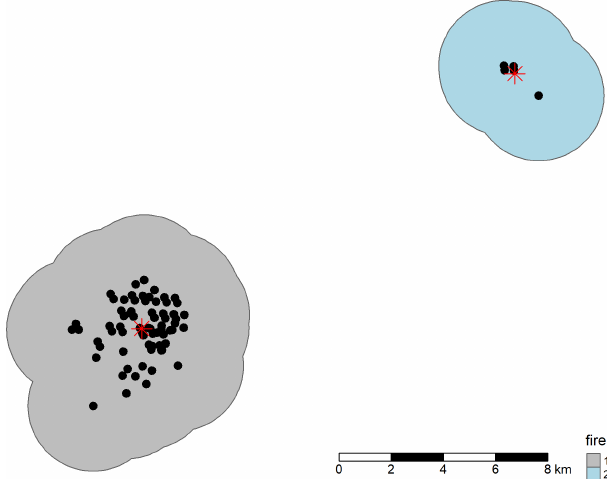
Figure 2. Example of creating clusters from VIIRS SNPP hotspots. Black dots are hotspots; red asterisks are fire centroids, i.e. the arith- metic mean of the hotspot coordinates. The image has two sepa- rate fires. Each hotspot is buffered by 2.5km, with all overlapping buffers merged and hotspots given separate identity numbers based on which final buffer they fell within. Two separate fires are cre- ated here because of distinct fires where buffers do not overlap, i.e. greater than two buffer widths (5km) apart. Fire 1 (grey) has > 50 hotspots; fire 2 (blue) has 5 hotspots. Note that the fire area used in analysis was calculated via an intersection of hotspots with a 500m × 500m grid and not via buffer size (see